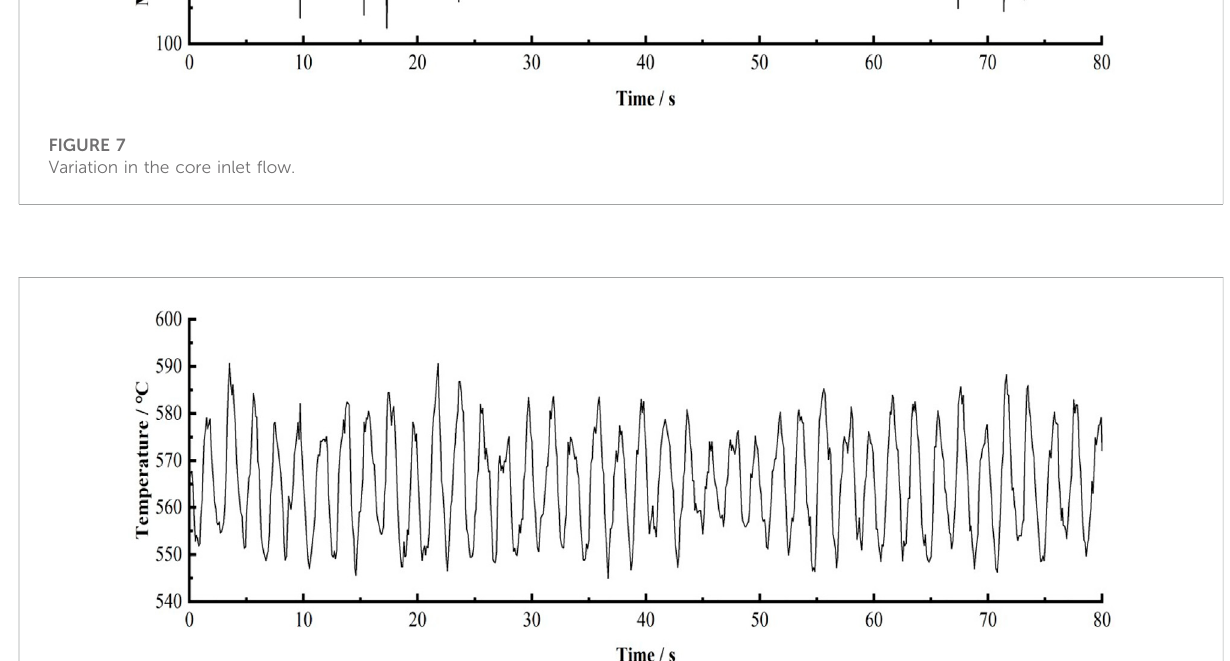
FIGURE 8 Variation in the maximum surface temperature of the fuel rod